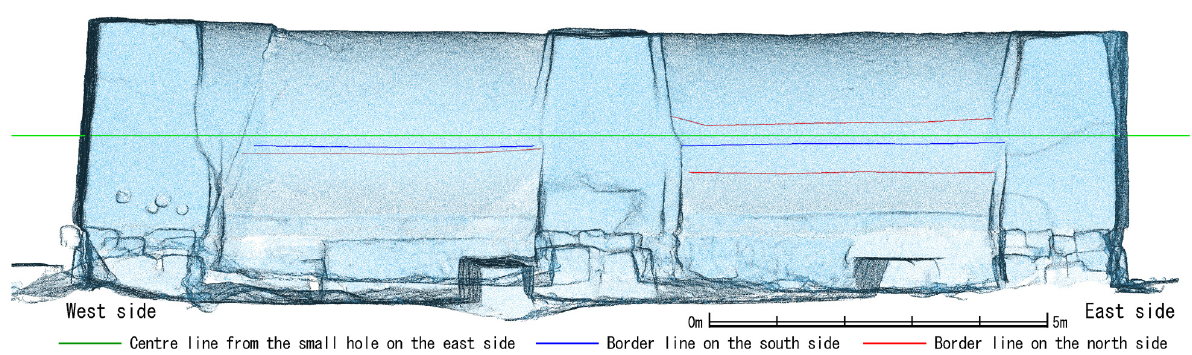
Figure 6. Comparison the centre line of the column with the border line of the chisel marks on the north and south